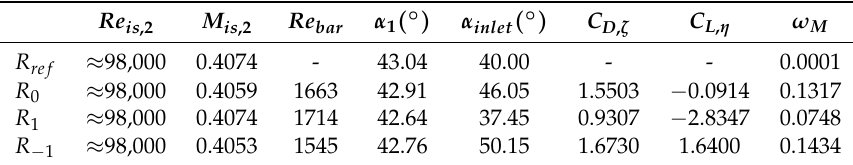
Table 2. Resulting low-pressure turbine flow